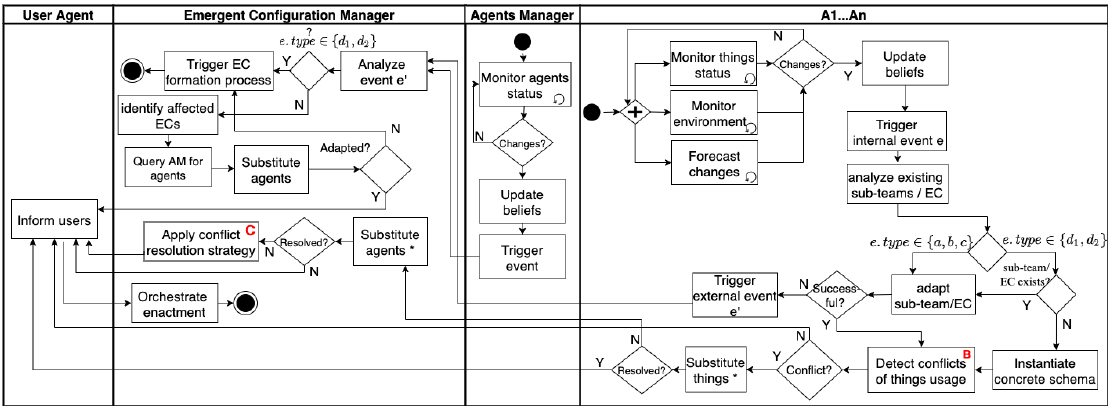
Figure 4. ECs adaptation